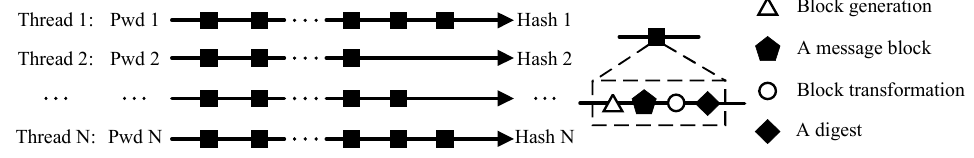
Figure 2: Computation model of the brute-force attack on KDFs. N passwords are processed concurrently with N KDF threads. Each block depends on its previous